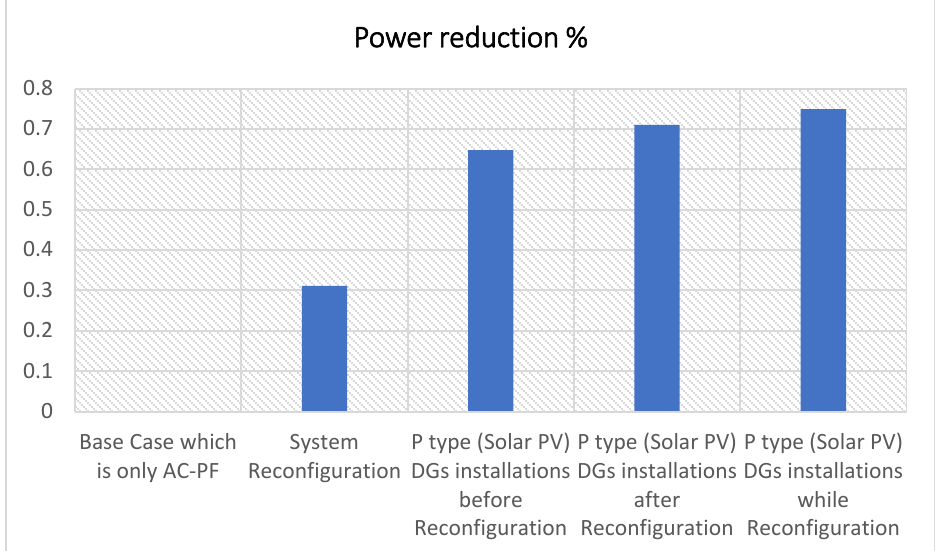
Figure 7. Power reduction in P-type (solar PV) DG installations depending on the reconfiguration process using GWO.